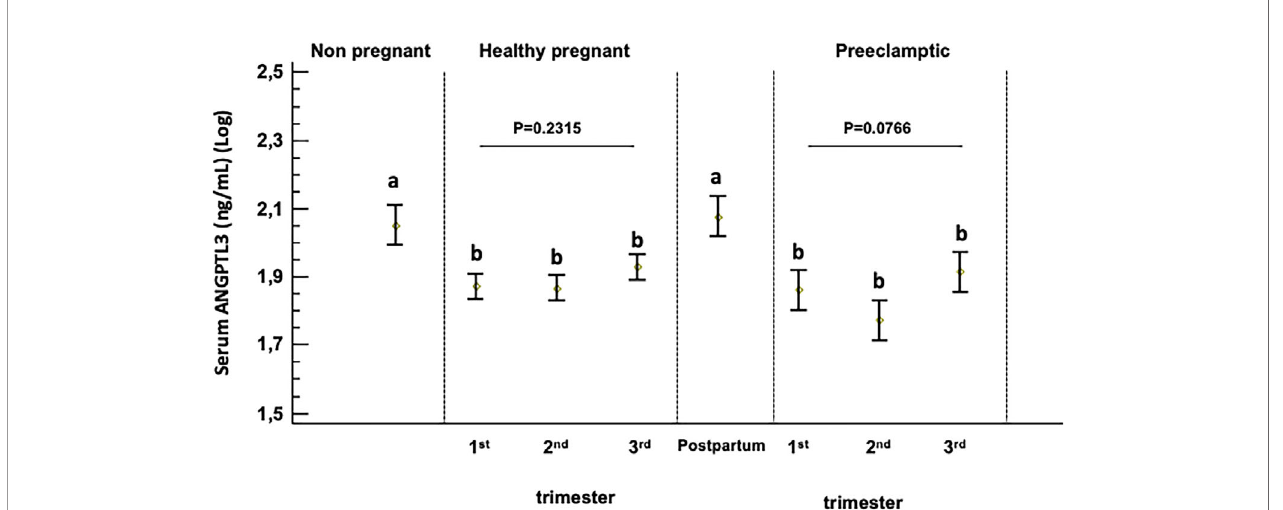
Different superscript letters (a and b) indicate which means differ signi fi cantly from which other (p<0.05) and described in statically method section. Log-transformed (log10) values were used.